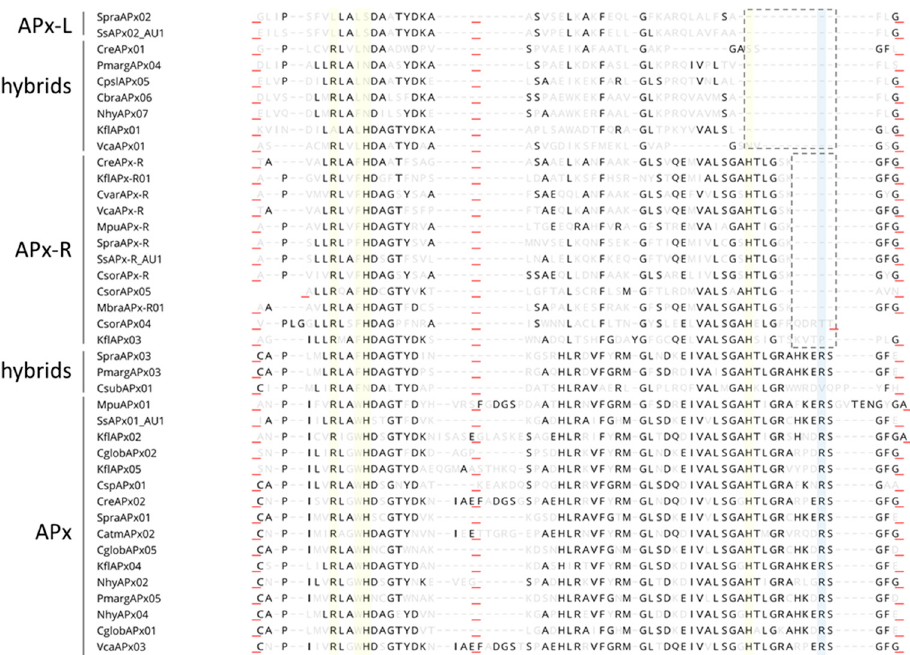
Figure 6. Mutations and two small deletions are involved with APX-R and APX-L establishment. Representative sequences of each protein category were retrieved from RedOxiBase, and domains that contain relevant residues are shown. Conserved residues are shown in black and others, in light grey. Positions implicated with catalytic activity are shown in yellow and with ascorbate-binding, in blue. While mutations seem to be responsible for the progressive loss of N-terminal catalytic residues, two small deletions appear to be the main cause leading to Arg172 and His163 loss. The alignment is shown from protein position 32. Red underscores evidence of domains collapsing for better